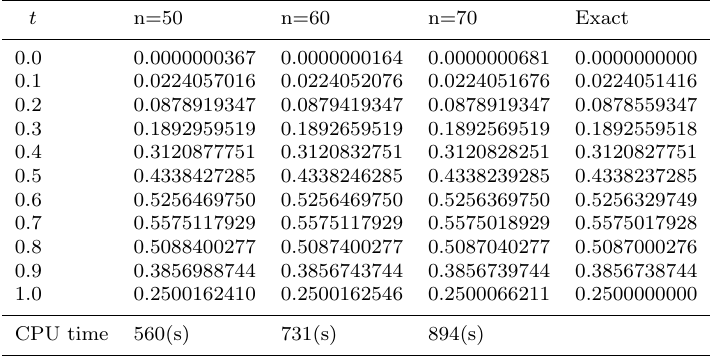
Table 2. Estimated and exact value of x ( t ) for n = 50 , 60 , 70 of Example 2.